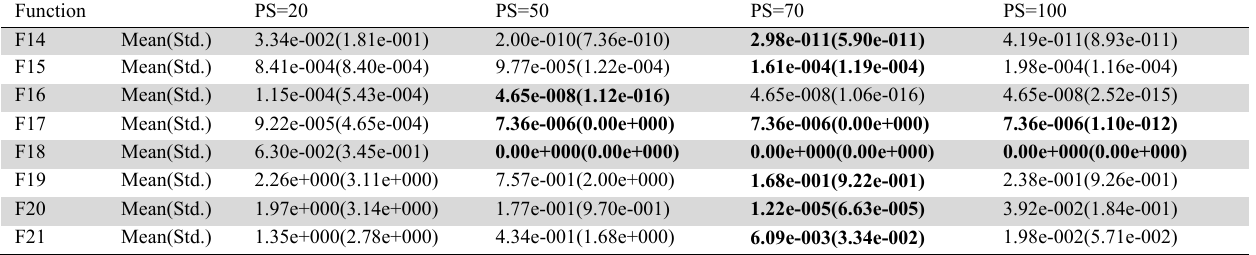
Comparative statistical results of 8 benchmark function (F14-F21) of E-BSADE for different values of population size (PS) over 30 runs, after 10000 function